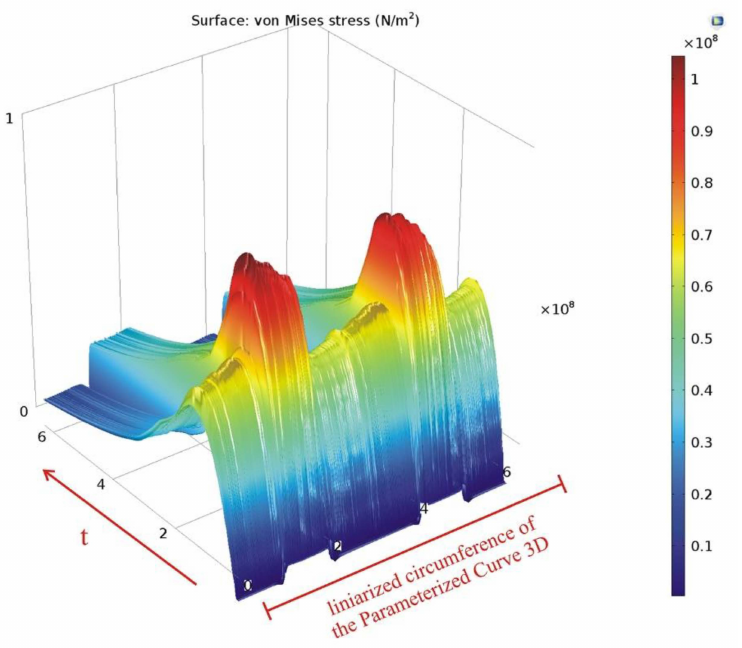
Figure 17. Variation in time of the von Mises stress along the parameterized